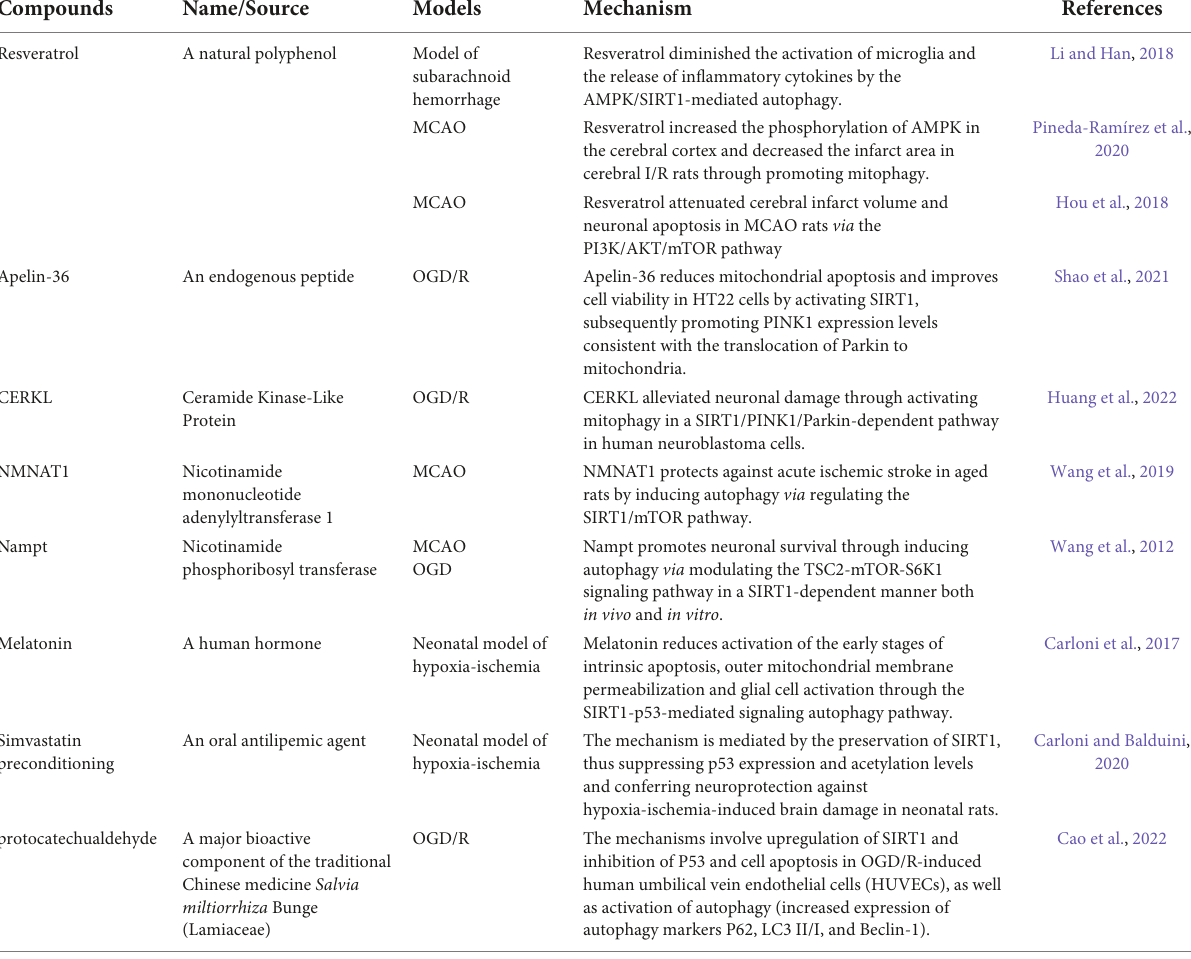
TABLE 2 Mechanisms of therapeutic compounds on silent information regulator 1 (SIRT1)-mediated autophagy in different ischemic models.